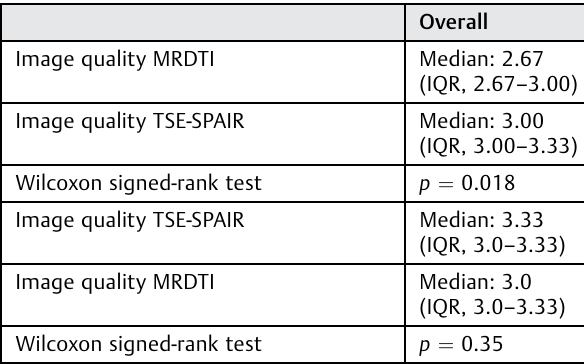
Table 4 Overall image quality of MRDTI and TSE-SPAIR